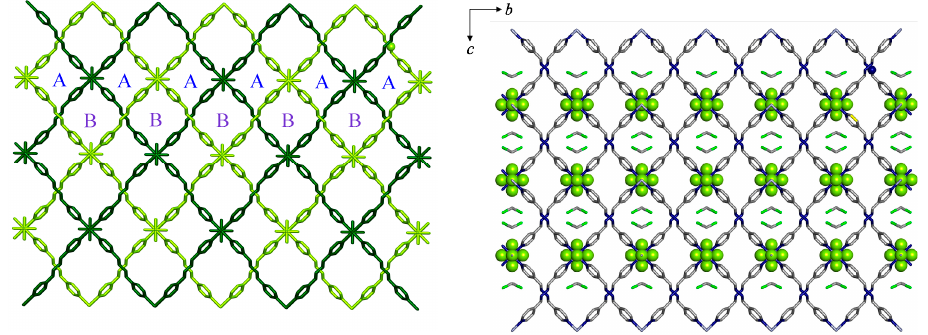
Figure 2. ( a ) Packing diagram along a -axis of IPM-325_p1 with guests solvent molecules present within the one-dimensional pore channel. ( b ) Packing diagram of IPM-325_p1 along a -axis depicting two-fold interpenetration along with two kinds of pore. (Hydrogen atoms have been omitted for clarity) Color: Grey—C, Light Blue—N, Dark Blue—Zn, Green—Fluorine, Red—Silicon, Light green—Chlorine. Solvent hidden for clarity.